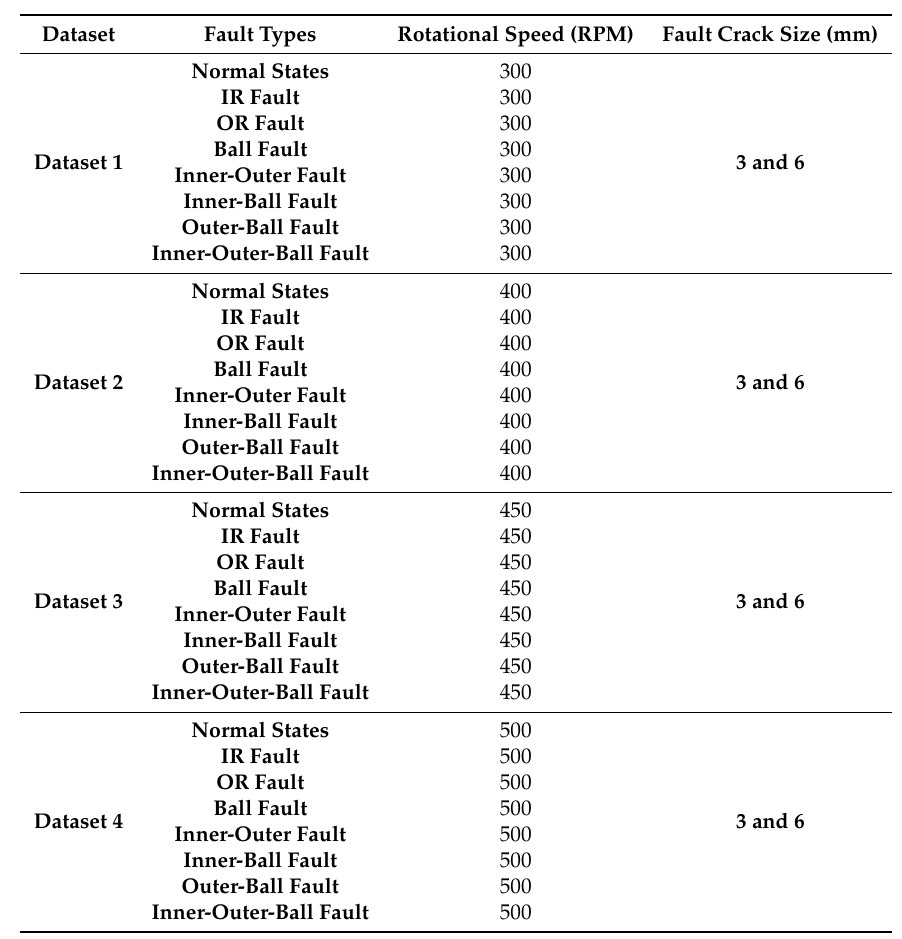
Figure 3. Different fault conditions in a bearing: ( a ) outer raceway fault, ( b ) inner raceway fault, ( c ) ball raceway fault, ( d ) inner-outer raceway fault, ( e ) inner-ball raceway fault, ( f ) outer-ball raceway fault, and ( g ) inner-outer-ball raceway fault. Table 1. Detailed information of the datasets.